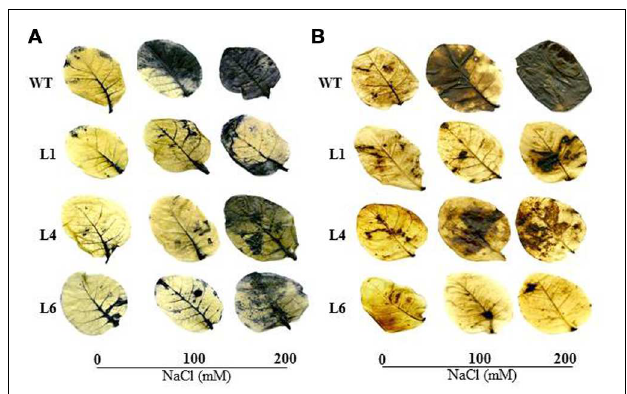
FIGURE 5 | In vivo localization of O 2 − and H 2 O 2 in leaves of WT and transgenic lines grown in hydroponic medium. (A) Localization of O 2 − by NBT staining, (B) Localization of H 2 O 2 by DAB staining in the presence of 0, 100, and 200 mM NaCl.